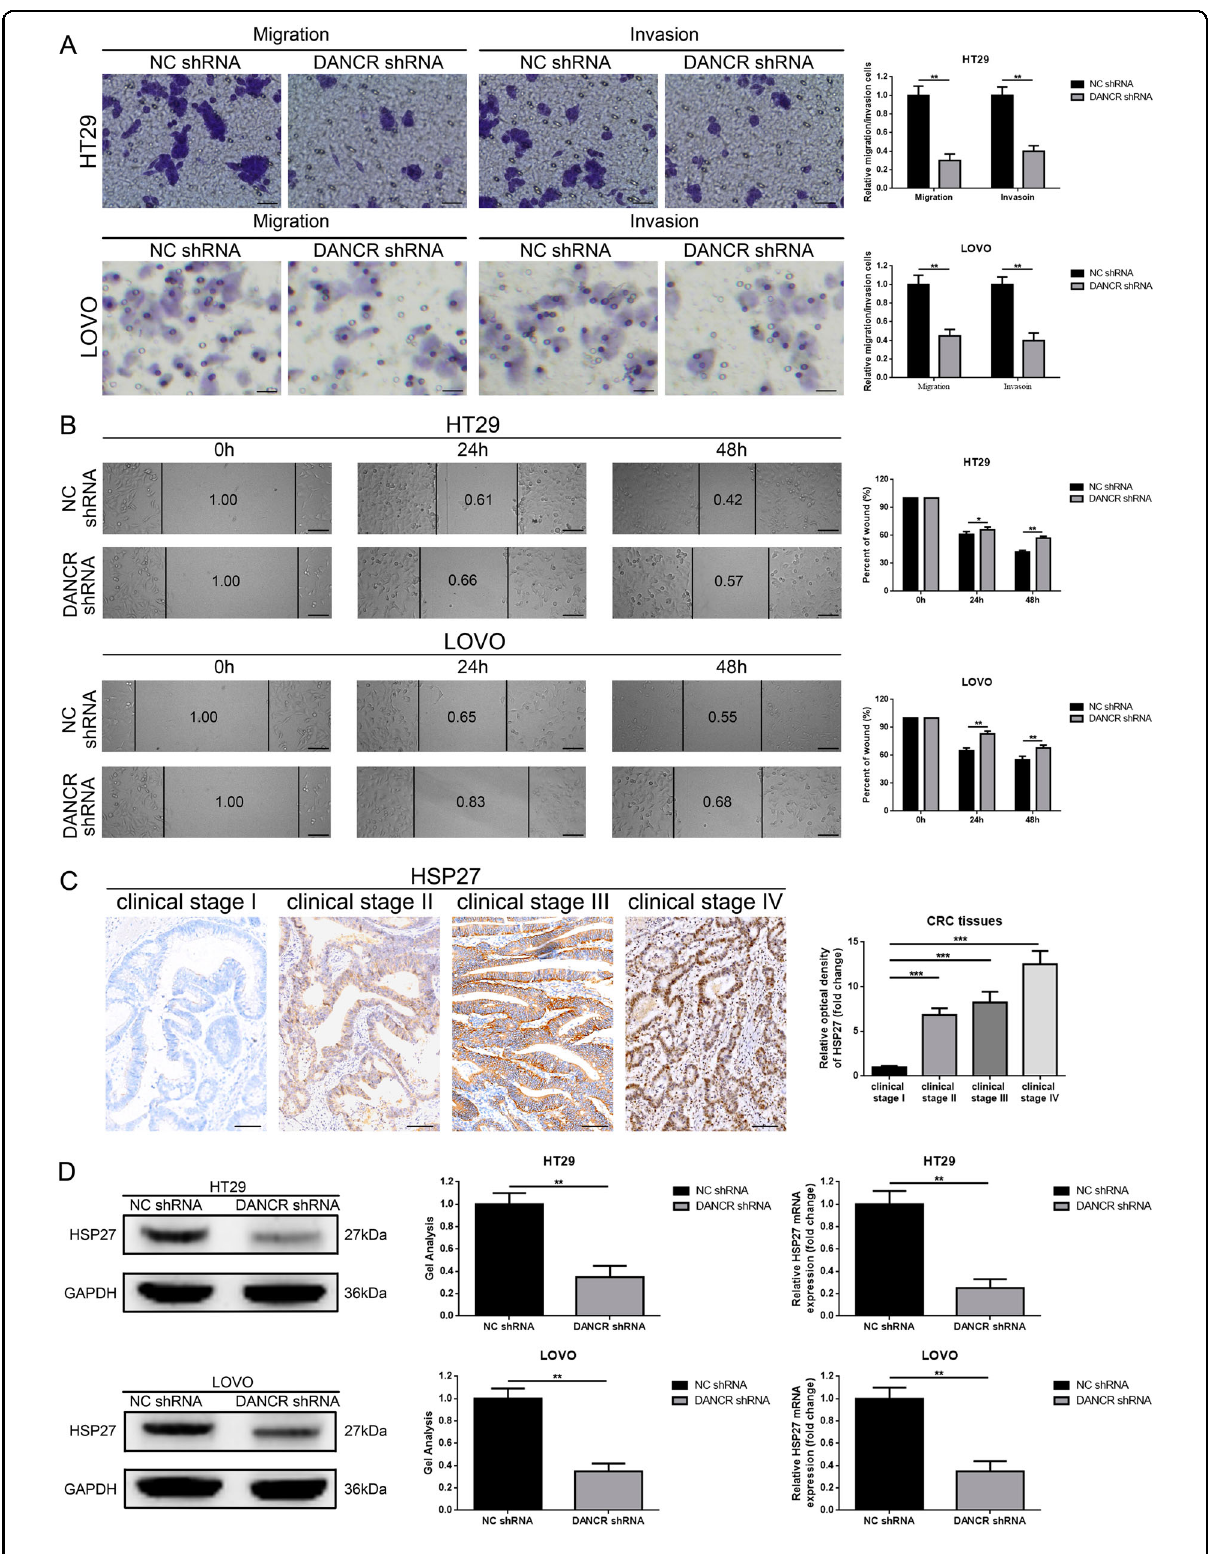
Fig. 3 (See legend on next